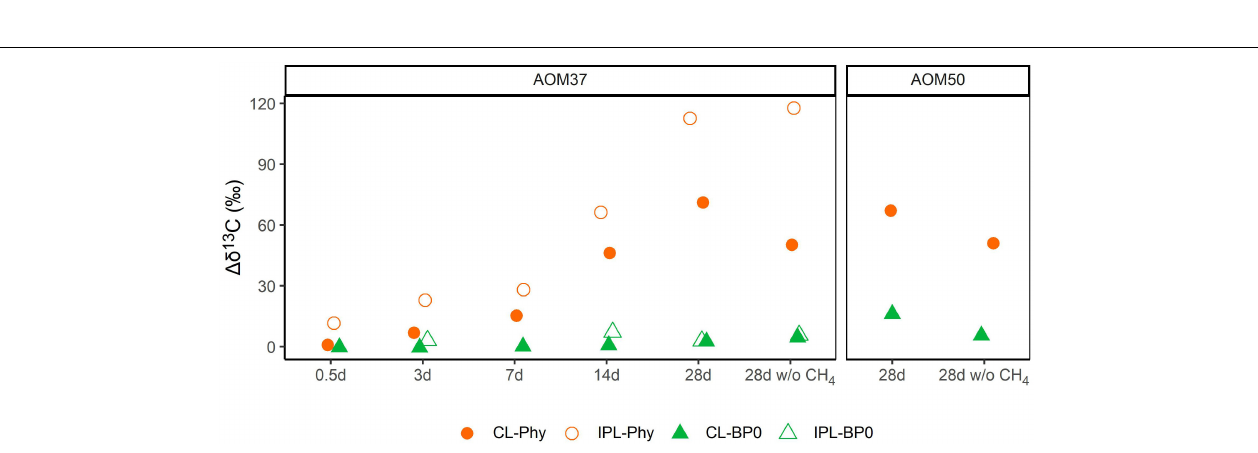
relative to T 0 ) of archaeal lipid-derived isoprenoid hydrocarbons during 13 C-leu incubation of AOM37 and AOM50 FIGURE 5 | Development of δ 13 C values (in cultures with and without (w/o) CH 4 over 28 days (experiments 1 and 3, respectively). In the AOM50 culture, the amounts of IPL-Phy and IPL-BP0 were too low to (cid:104) obtain δ 13 C